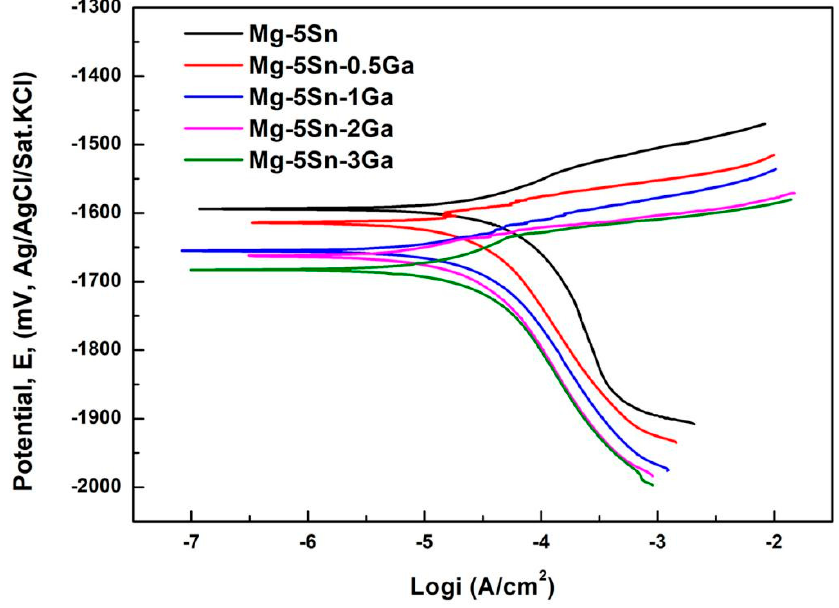
Figure 4. Polarization curves of the Mg–5Sn– x Ga alloys in 3.5 wt % NaCl solution.